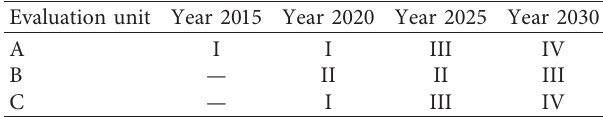
Table 2: Risk grade table for gas reservoir development planning